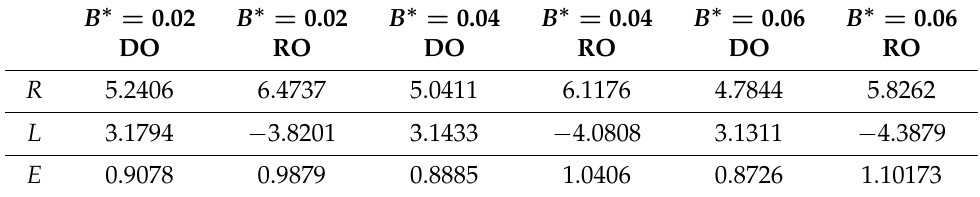
Table 4. Radii R of the ISCOs. The parameters are a = 0.2, Q ∗ = 0.008. DO represents a direct orbit, and RO denotes a retrograde orbit. Note that L with E is not arbitrarily given for the case of ISCOs, but it is for the case of stable circular orbits. R , E , and L are determined together in terms of the conditions of ISCOs.